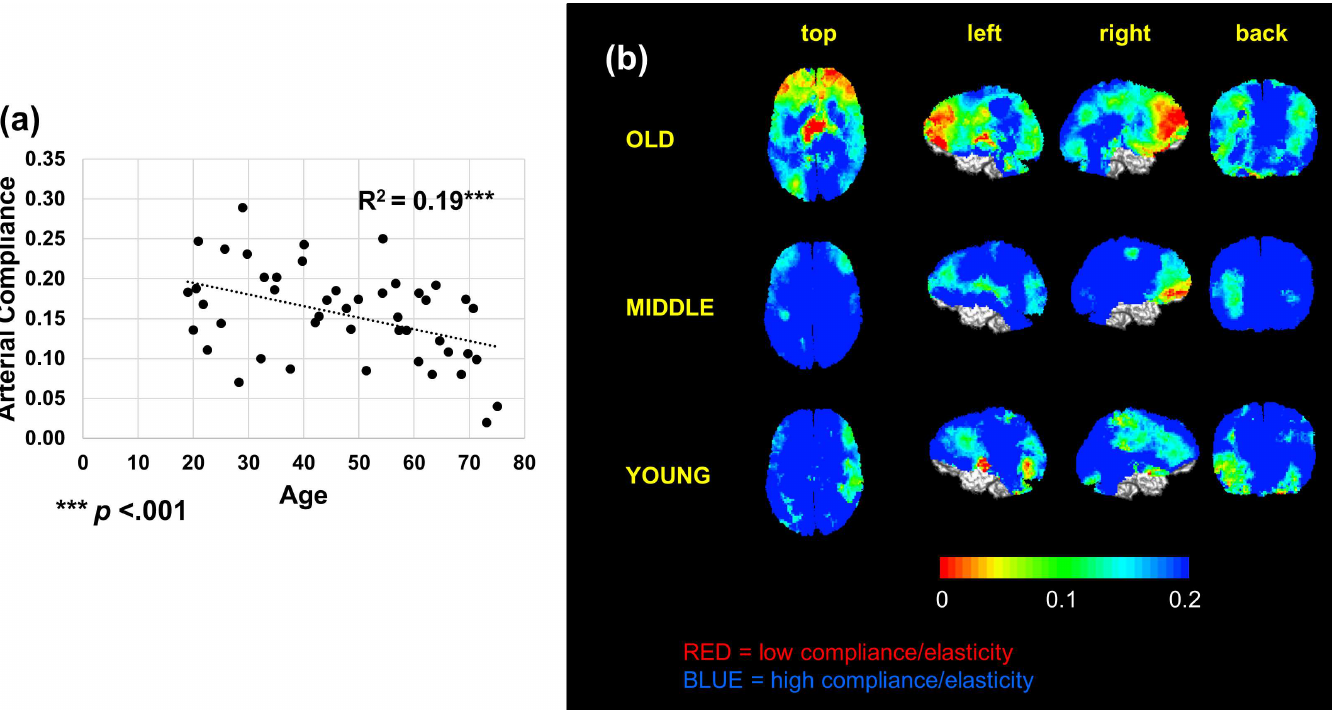
Fig 5. (a) Older age is associatedwith lower arterial compliance(i.e., greater arterial stiffness). b) Arterial compliance maps derivedfrom age tertiles. Cortical arterial complianceis projectedonto the brain surface. Compared to youngersubjects, older subjects appearto show poorer arterial compliance(red regions), especiallyin